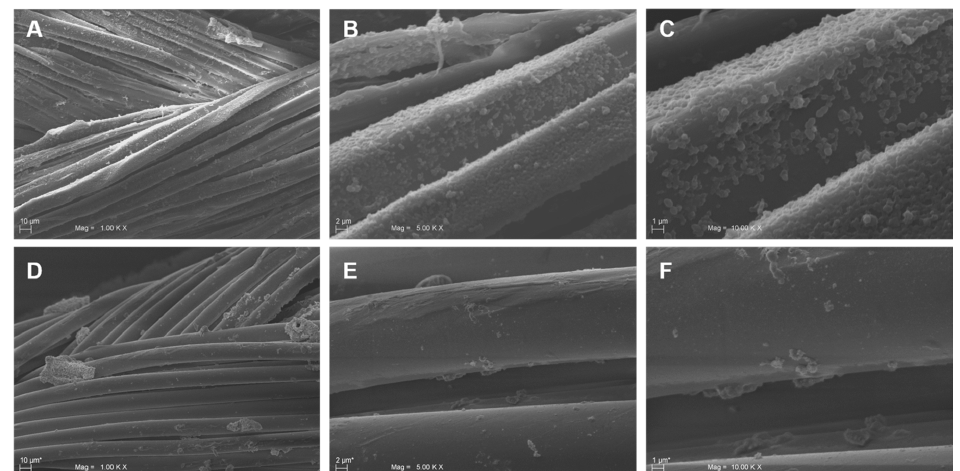
Figure 6. Representative SEM images of sutures untreated and treated with the medical device (MD). Panels A , B , and C represent different magnifications of untreated sutures with E. faecalis cells adhered on the surface of the threads. E. faecalis aggregates forming a biofilm were visible on panels B and C . On the contrary, few cells were attached on the suture surface of MD-treated samples ( D , E , F ).